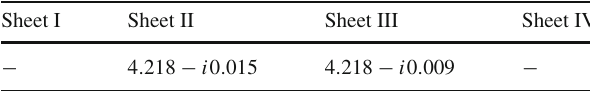
Table 4 Pole positions of X ( 4260 ) . The value of i (cid:8) pole / 2 is given in unit of